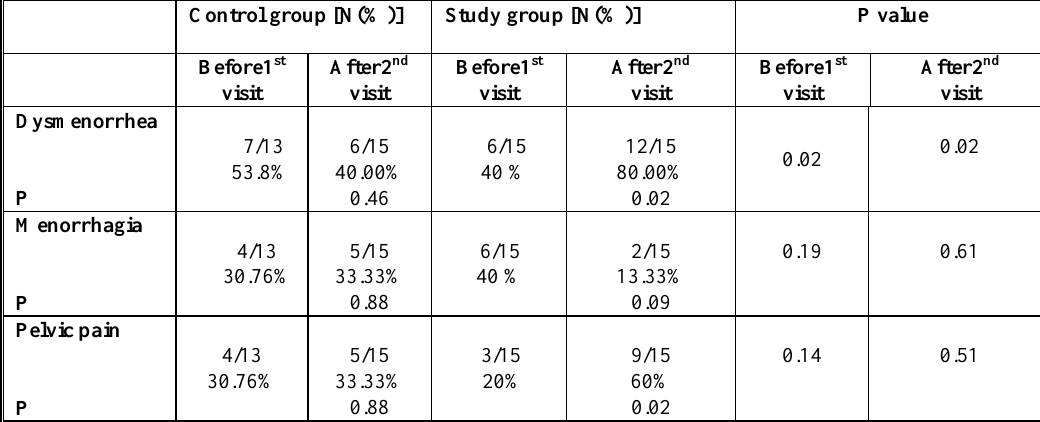
Table(9): Changes in clinical symptoms in endometriosis control and study group before and after three months of treatment